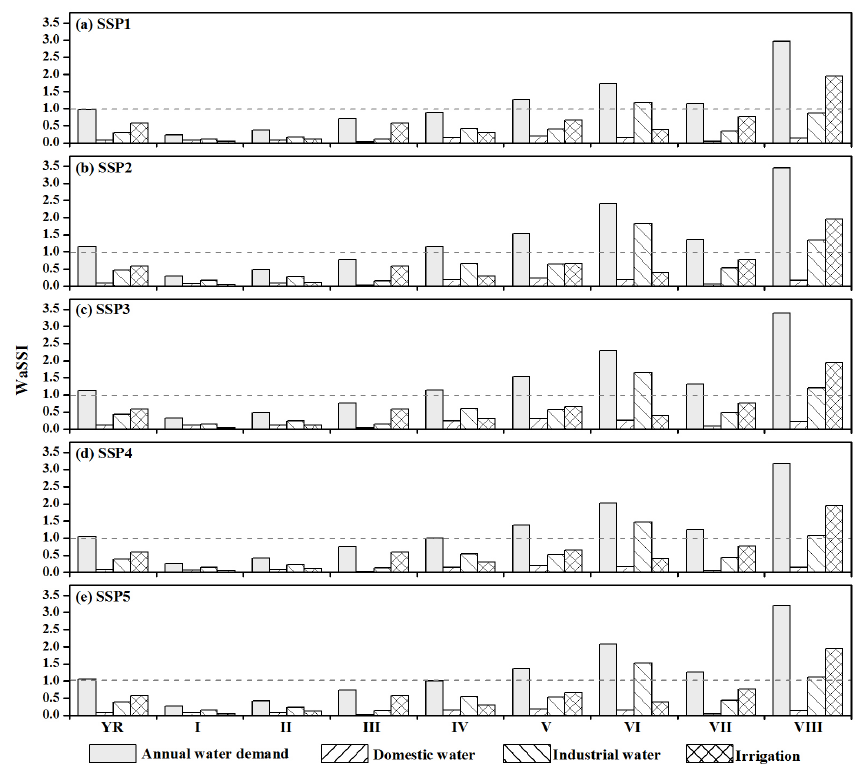
Figure 6. WaSSI calculated as the ratio of annual water demand and sectoral (domestic, industrial, and irrigation) water withdrawals to annual water supply for the YR basin and eight sub-basins at the end of the 21st century under the five different SSPs. The annual water supply was estimated with an RHWA value of 50% (RHWA50).